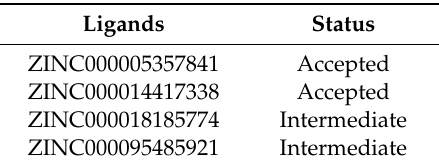
Table 5. Free ADME-Tox Filtering results showing ligands that passed the physicochemical filtering rules with no structural alerts.